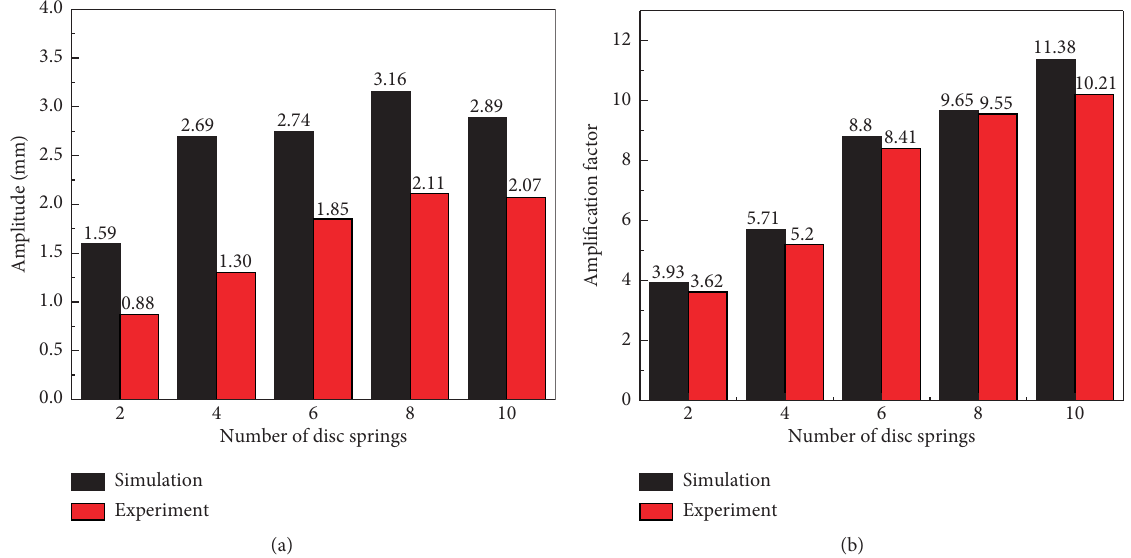
Figure 9: Amplitude and amplification factor of disc spring system in constraint of locking and no preloading under different numbers of disc